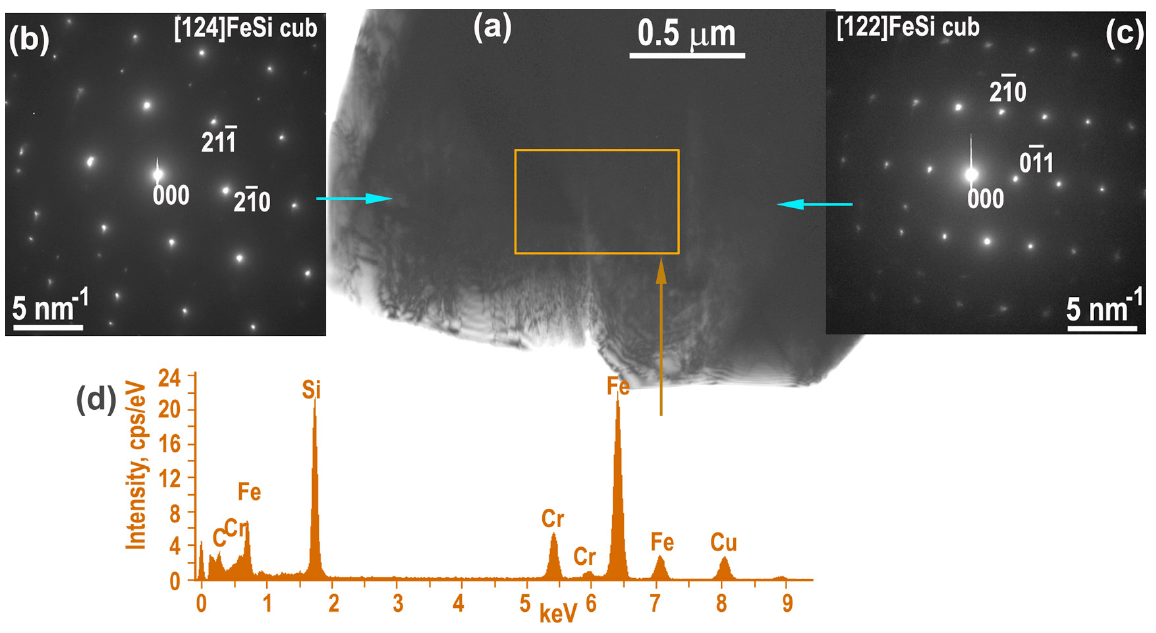
Figure 5. Non-annealed sample: FeSi grains from the network from. EDXS elemental map (containing